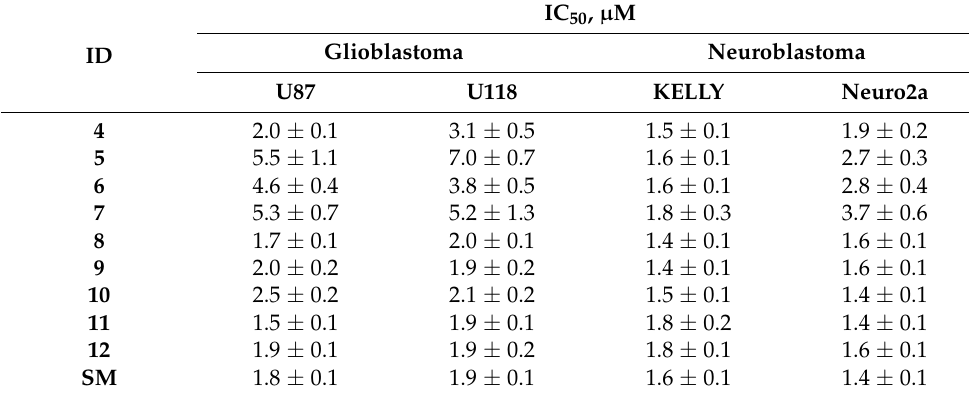
Table 2. Cytotoxicity of novel soloxolone amides in brain tumor